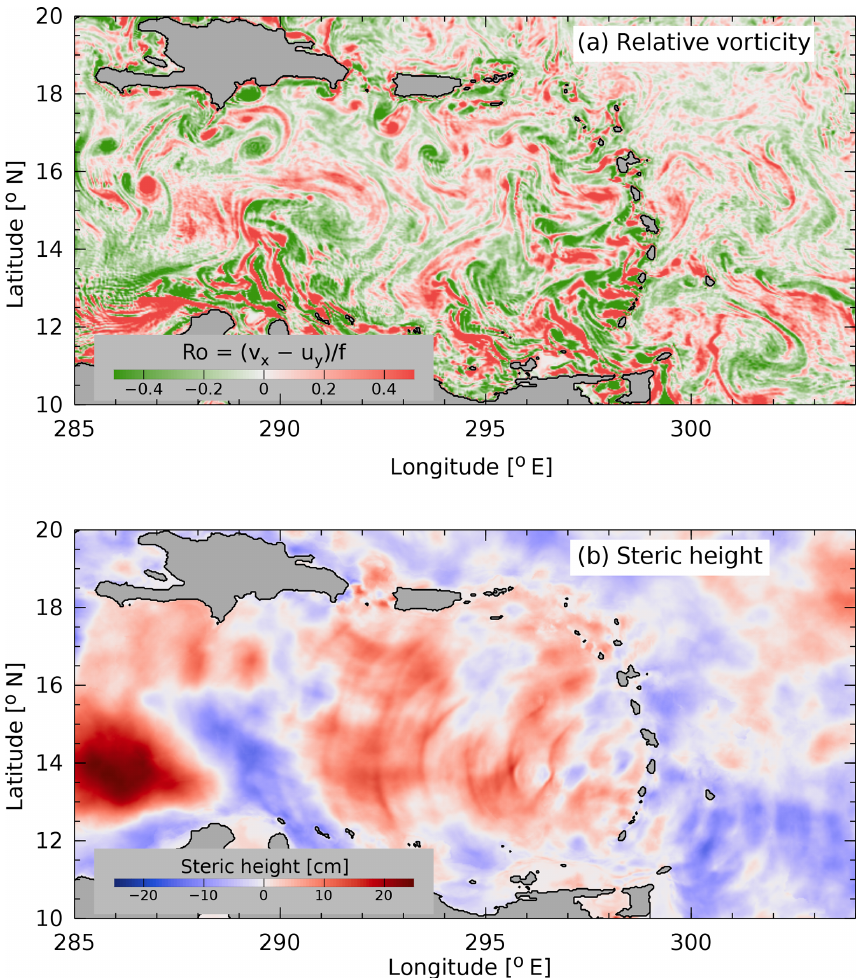
Figure 3. Snapshots of AMSEAS model outputs valid on 2 January 2013. (a) The relative vorticity field (expressed as a Rossby number) contains a spectrum of small circular eddies and filamentous structures. (b) Steric height anomaly (relative to the 2-year